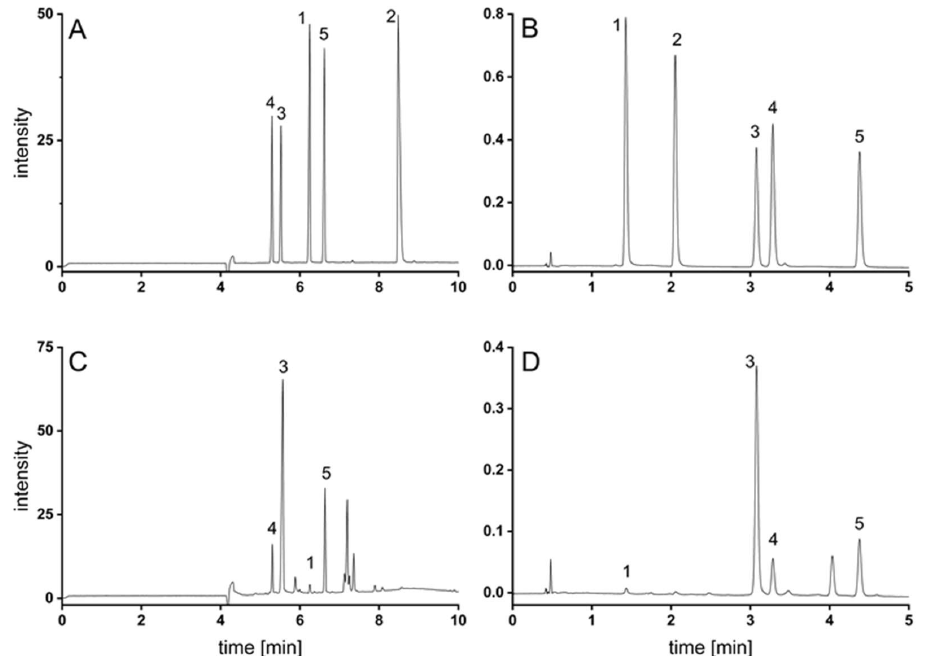
Figure 2. Optimal separation of DHCs by CE (( A ): standard mixture, ( C ): sample Malus-2 ) and SFC (( B ): standard mixture, ( D ): sample Malus-2 ). CE: 25 mM borax (sodium tetraborate tetrahydrate) buffer containing 2.5% isopropanol at pH 8.25; injection: hydrodynamic (50 mbar, 3 s); voltage: 25 kV and temperature: 30 °C; detection: 210 nm; SFC: Torus™ Diol (3.0 × 100 mm; 1.7 µm particle size); mobile phase: CO 2 ( A ) and 2.5 mM oxalic acid in methanol ( B ), gradient from 30 to 45% B in 4.5 min, held for 0.5 min; flow rate: 1.10 mL/min; column temperature: 40 °C; ABPR: 2000 psi; injection volume: 1 µL; detection: 280 nm. Peak assignment according to Figure 1.